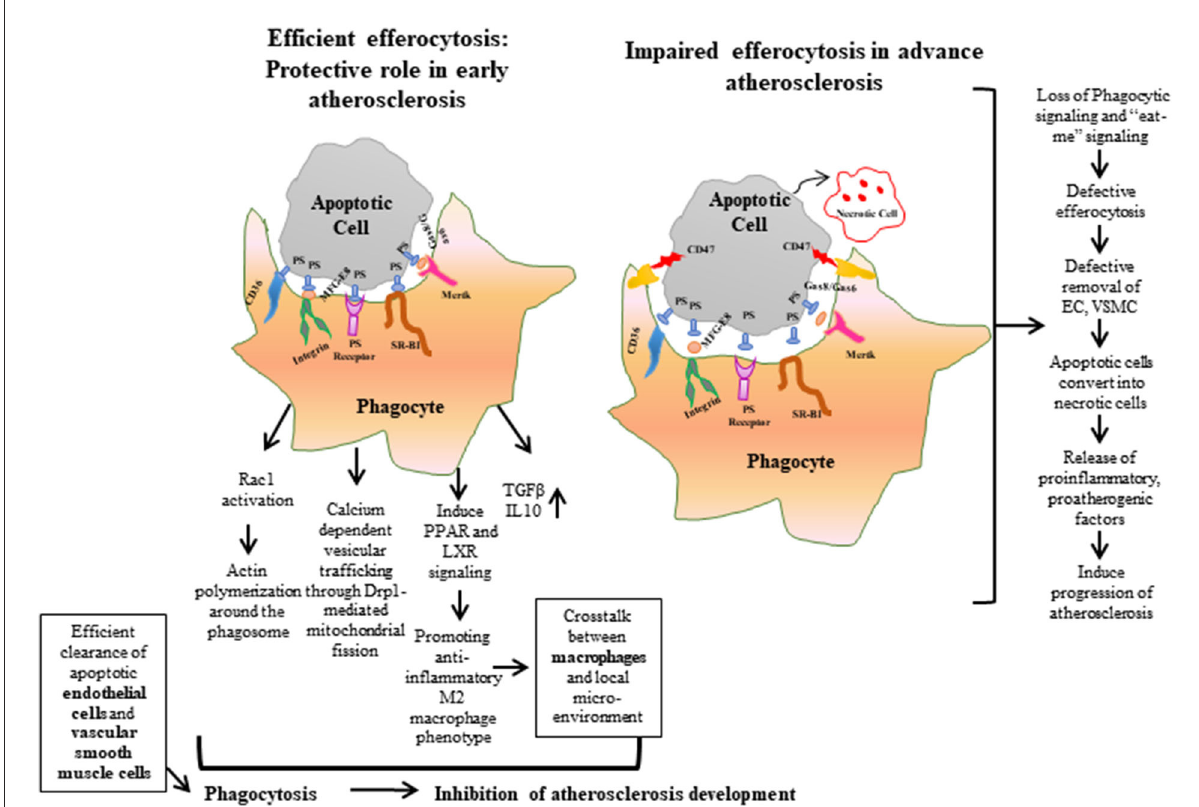
FIGURE1 Efferocytosis is the phagocytic process required for maintaining normal vascular hemostasis. Efficient efferocytosis plays an important role in protecting against atherosclerosis by inducing phagocytic signals or “eat-me” signals and clearing apoptotic debris. Conversely, in defective efferocytosis, the phagocytic signals are reduced and the phagocytic ability of apoptotic cells is decreased. As a result, apoptotic cells are converted to necrotic cells, and accumulation of these uncleared cells form a necrotic core, which leads to the release of proatherogenic factors and progression of atherosclerosis plaque. ECs, Endothelial cells; VSMCs, Vascular Smooth Muscle